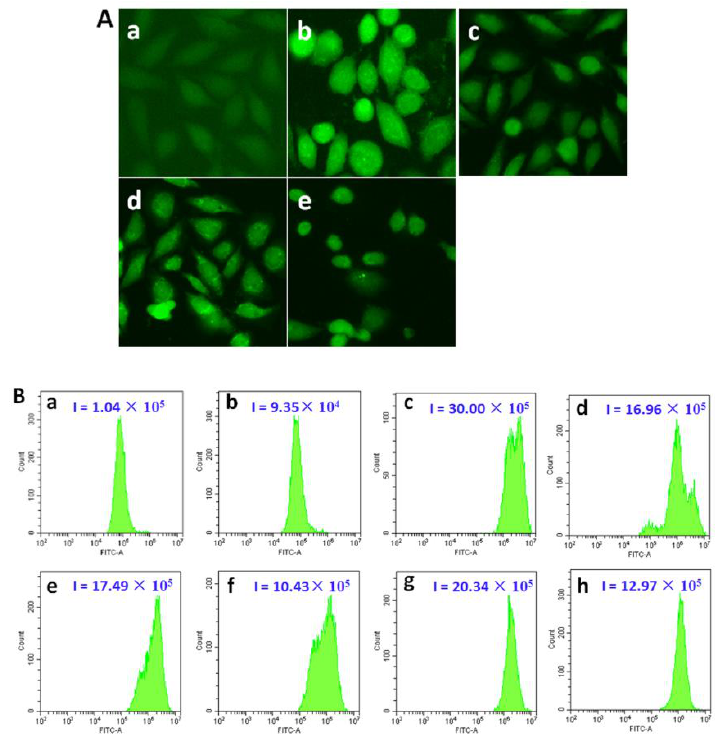
Figure 7. ( A ) Intracellular reactive oxygen species (ROS) detected in SGC-7901 cells (control, a) after exposure to Rosup (positive control) (b), 1 (4.0 µM) (c), 2 (15.0 µM) (d), or 3 (15.0 µM) (e) for 24 h. ( B ) Determination of DCF fluorescence intensity by flow cytometry after exposure of SGC-7901 cells (control, a) to N-acetylcysteine (NAC) (b), 1 (4.0 µM) (c), 1 (4.0 µM) + NAC (d), 2 (15.0 µM) (e), 2 (15.0 µM) + NAC (f), 3 (15.0 µM) (g), or 3 (15.0 µM) + NAC (h) for 24 h.